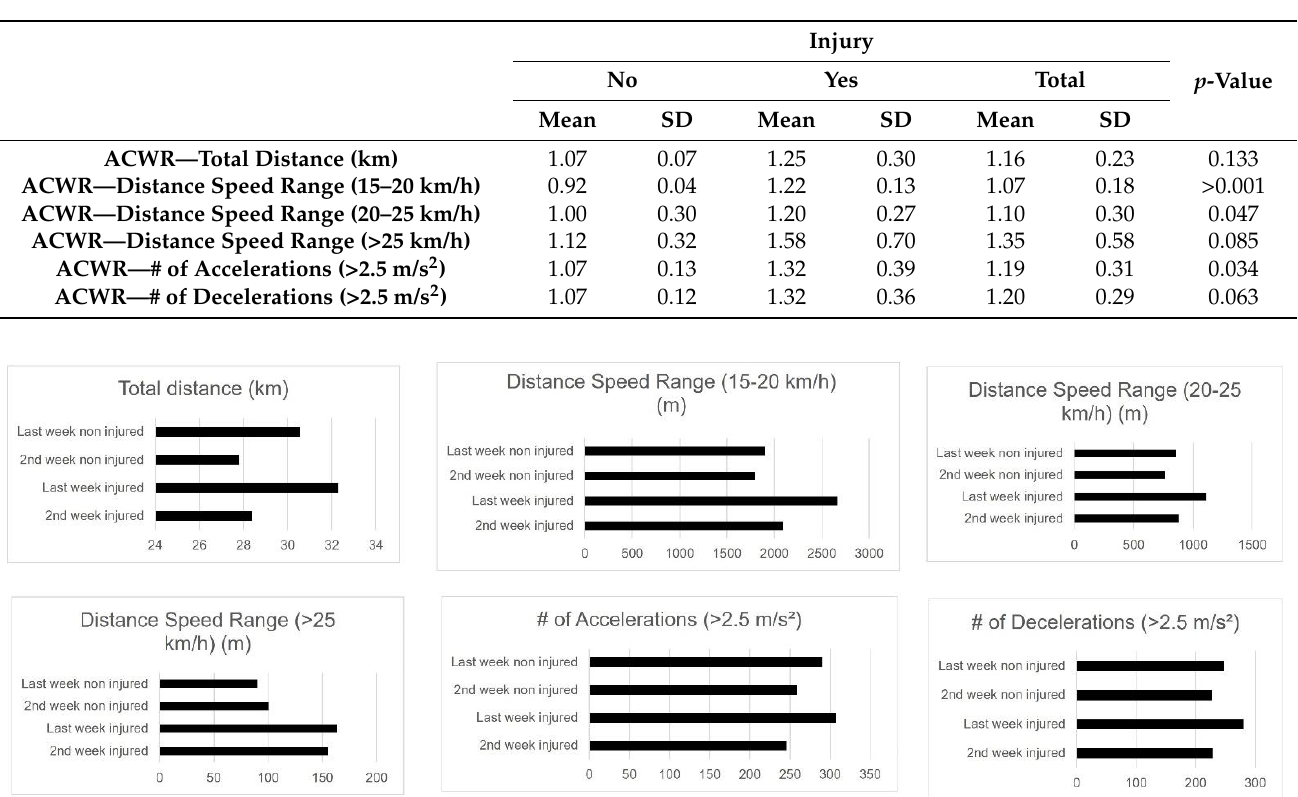
Table 1. ACWR values for four weeks model (mean ± SD).